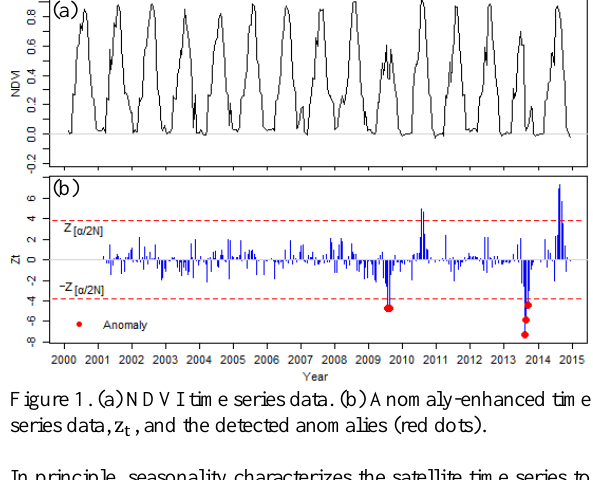
Figure 1. (a) NDVI time series data. (b) Anomaly-enhanced time series data, z t , and the detected anomalies (red